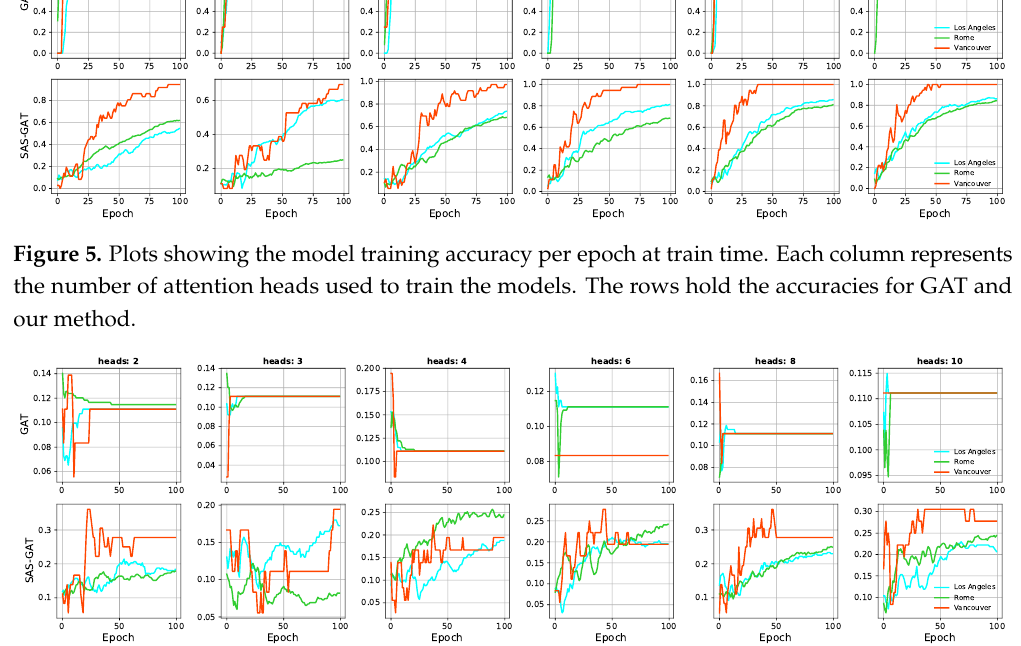
Figure 6. Plots showing the model validation accuracy per epoch for the validation set. Each column represents the number of attention heads used to train the models. The rows hold the accuracies for GAT and our